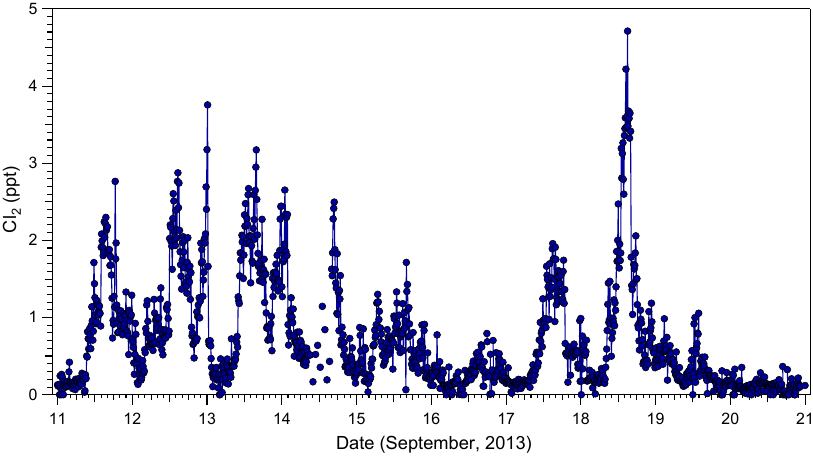
Figure 1. Time series of Cl 2 (10-min averages) at the Conroe, Texas measurement site from 11–21 September.